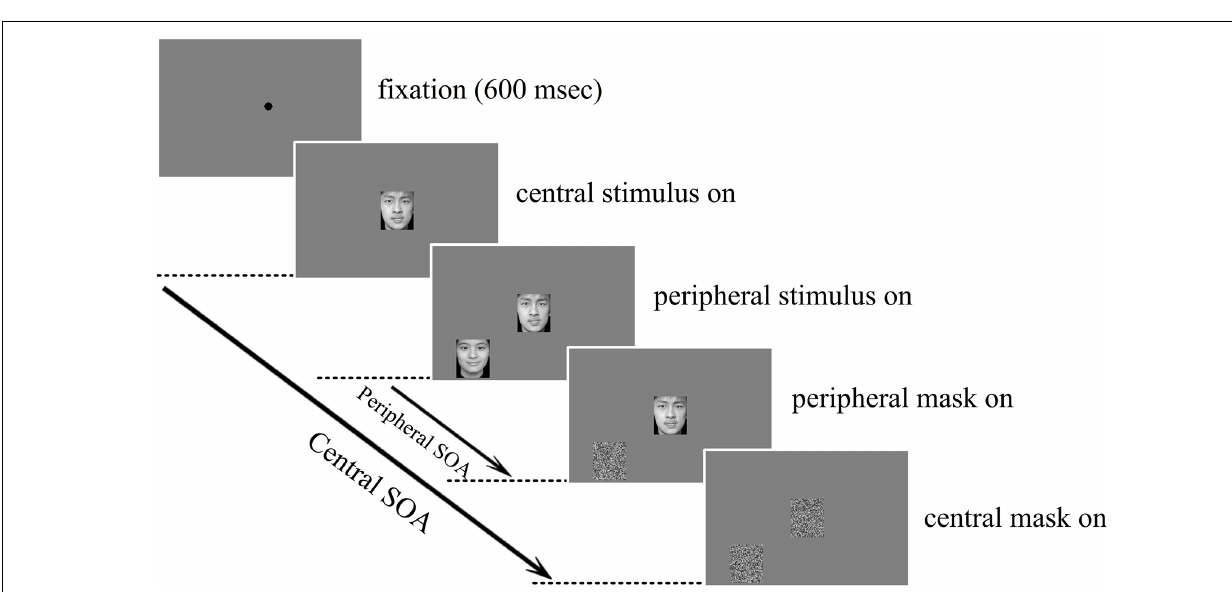
FIGURE 1 | Schematic illustration of one trial in the central letter – peripheral emotional face discrimination experiment. Subjects were required to report whether the five central letters were the same or different and whether the peripherally presented emotion was positive or negative. Both the letters and the faces were masked individually after the corresponding stimulus onset asynchrony (SOA).